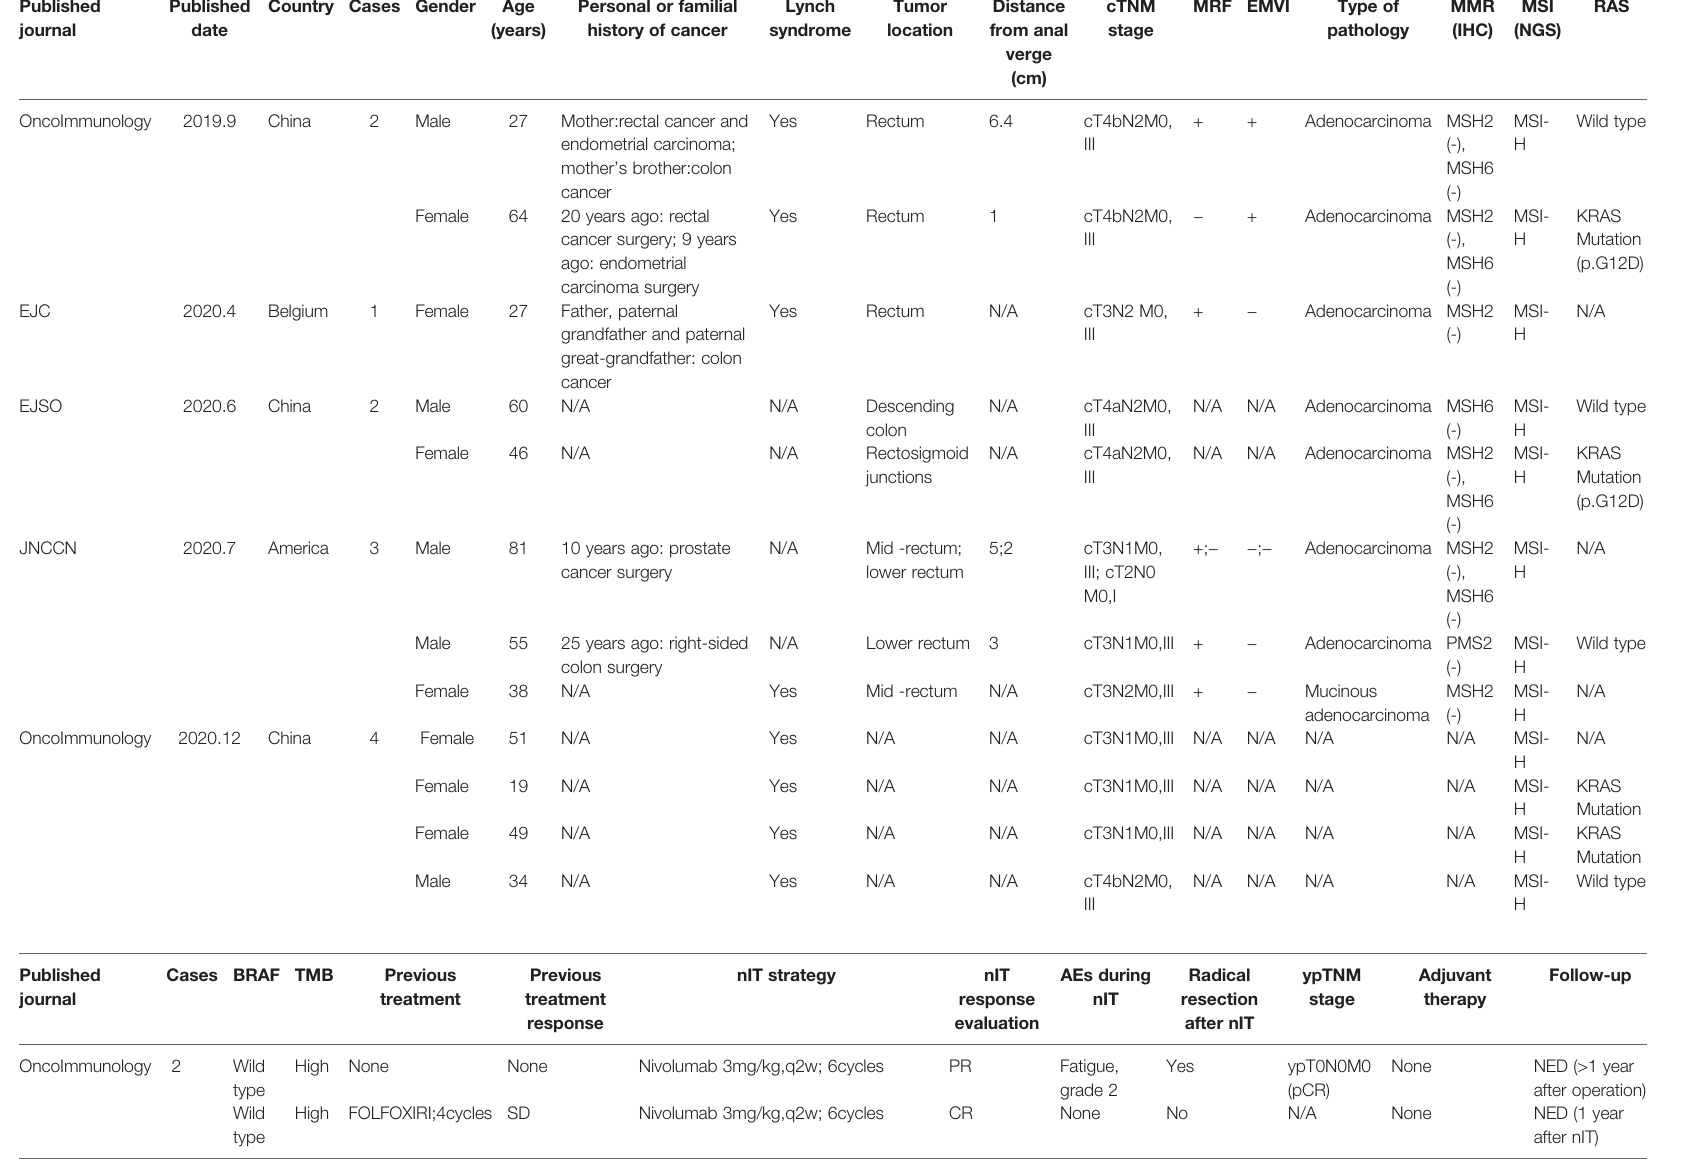
TABLE 3 | Retrospective studies of nIT for MSI-H/dMMR